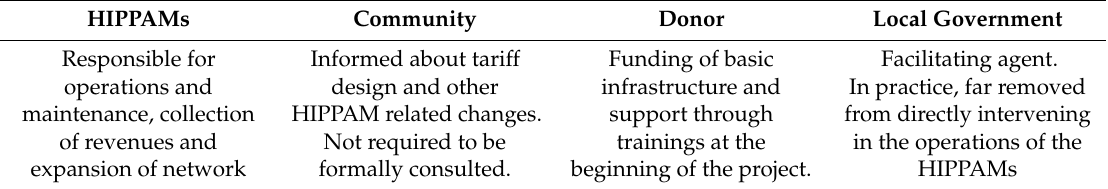
Table 1. Overview of responsibilities.